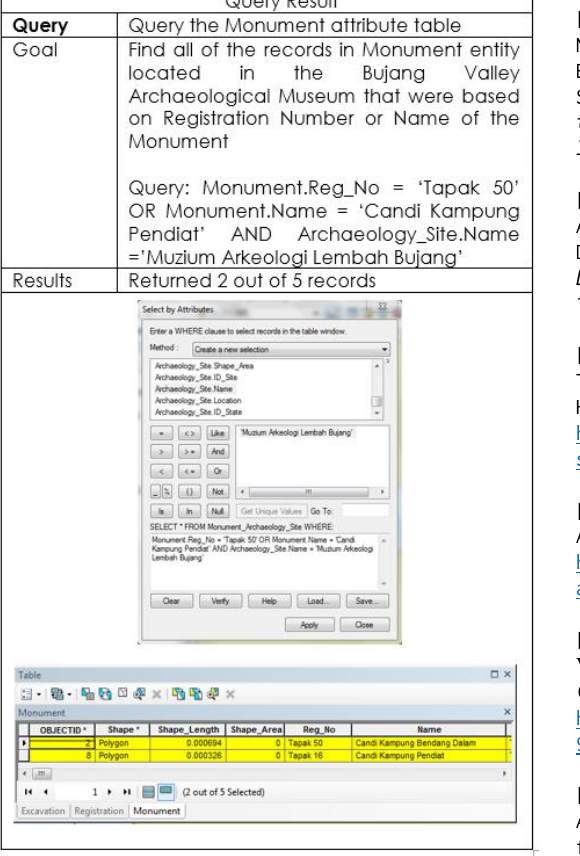
Figure 9: Result of the query process in geodatabase